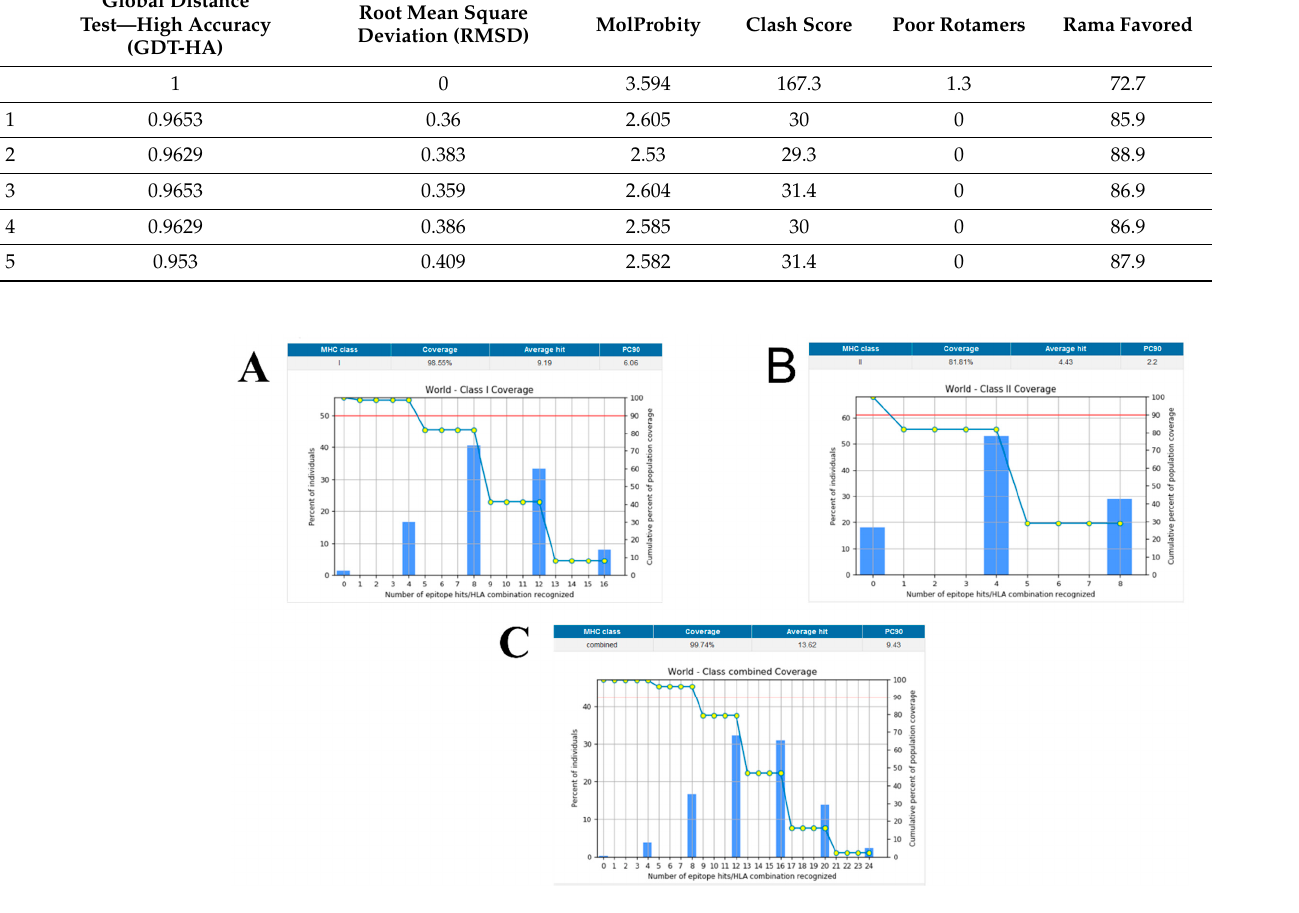
Figure 3. ( A ) World population coverage for MHC class I. ( B ) World population coverage for MHC Class II. ( C ) Combined world population coverage for HLA allele recognized as T-cell epitopes.